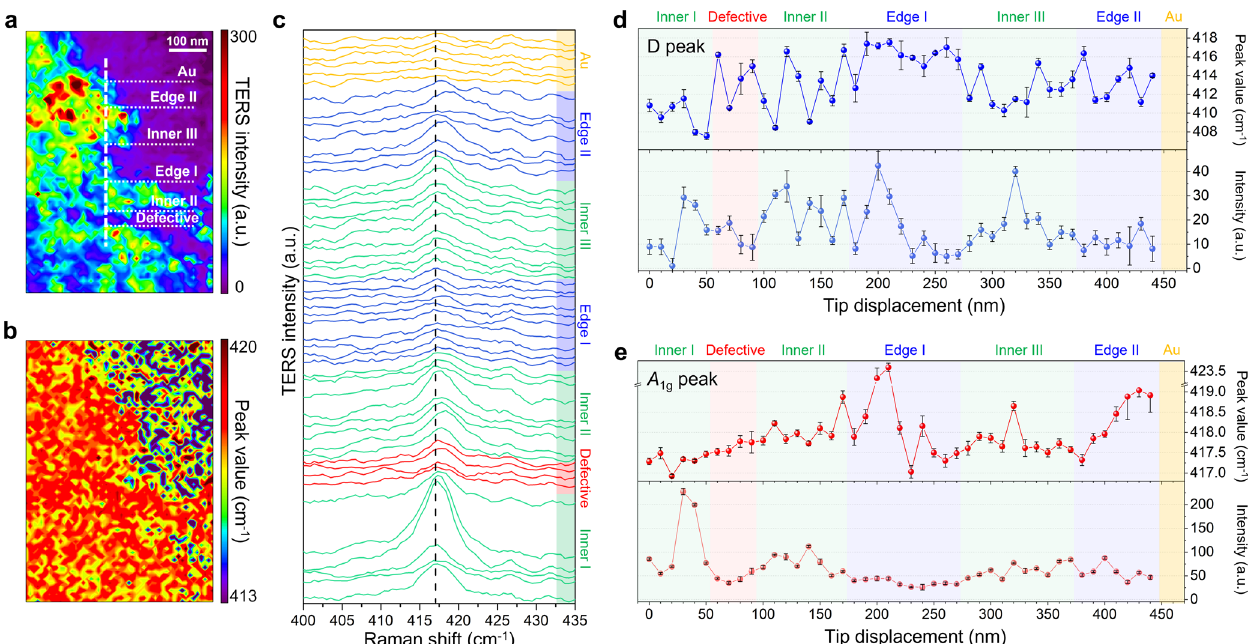
Fig. 4 TERS imaging for the localized edge region. a High-resolution TERS image for A 1g peak area intensity. The white dashed line indicates the positions of the extracted TERS spectra in ( c ). b Peak distribution TERS image derived from ( a ). c TERS spectral line trace for D and A 1g peaks. Each TERS spectrum was extracted at an interval of 10 nm. The black dashed line indicates the Raman shift of 417 cm − 1 . Plots of peak values and intensities for d D peak and e A 1g peak, with respect to tip displacement. The error bars indicate the fi tting